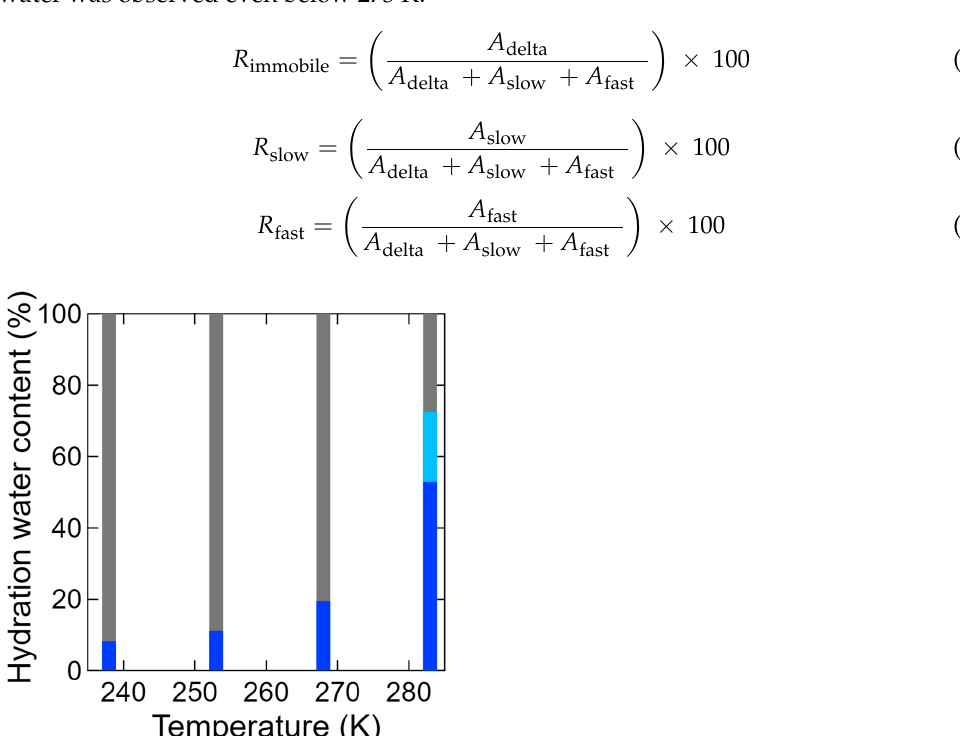
Figure 10. Temperature dependences of the ratios of the three types of hydration waters at 238, 253, 268, and 283 K, as determined by Equations (5) – (7). The hydration water contents for the slow and fast mobile waters and for the immobile water are denoted by blue, light blue, and gray, respec- tively.